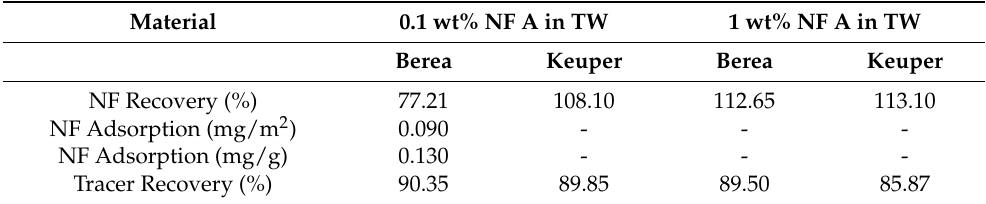
Table 8. Adsorption calculation via mass balance following concentration calculation using UV–Vis spectroscopy data for nanofluid B in Berea and Keuper outcrop core.